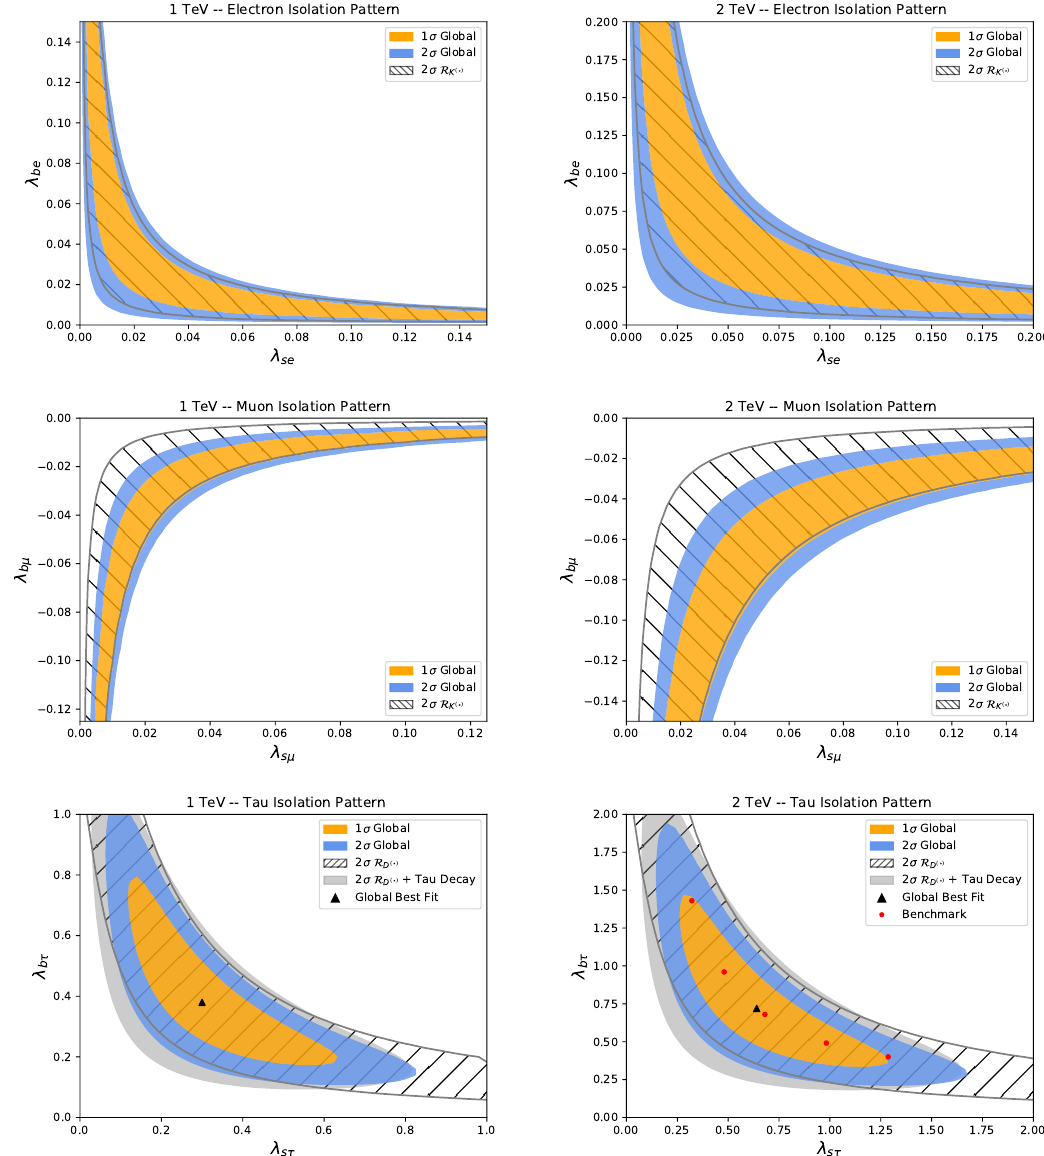
Figure 2 . Top left: likelihood contours for the two-parameter e -isolation pattern λ [ e ] at M ∆ = dl 1 TeV, including 2 σ contours from R constraints alone (hatched region), as well as global 1 σ K ( ? ) (orange region) and 2 σ (blue region) preferred contours considering all data available to smelli . Top right: the same, but for M ∆ = 2 TeV. Middle row: the same, but for the µ -isolation pattern λ [ µ ] . Bottom row: the same, but for the τ -isolation pattern λ [ τ ] , and including 2 σ contours from dl dl R constraints alone (hatched region), and R + τ decay modes (gray region). Here the global D ( ? ) D ( ? ) best-fit (black, triangular) and benchmark (red, circular) points in { λ sτ , λ bτ } we obtained from our scan are also